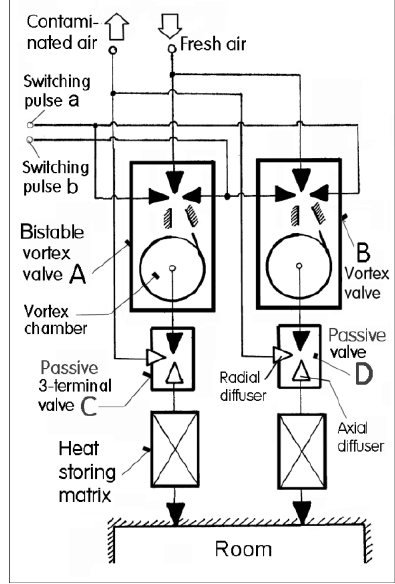
Fig. 22. Circuit diagram of an example of fluidic system recovering heat from the contaminated air [16] returned from the room and (at right) representation of the two air flows. Main components in this particular alternator are two bistable vortex valves Fig.